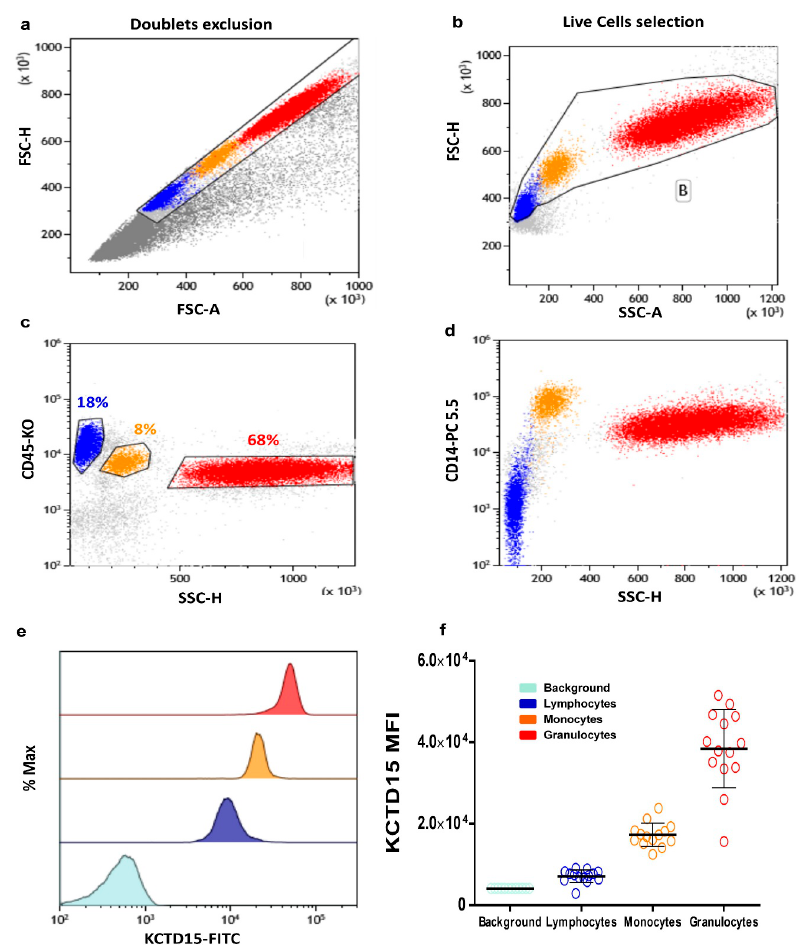
Figure 1. Potassium channel tetramerization domain (KCTD)15 expression in peripheral blood cells. ( a ) Forward scatter (FSC)-Height vs. FSC-Area dot plot used for the selection of single cells and doublets exclusion. ( b ) FSC vs. side scatter area (SSC) dot plot for the selection of single live cells. ( c ) CD45-KO vs. SSC color plot shows the identification of the lymphocytes (blue), monocytes (orange), and granulocytes (red) based on CD45 intensity of expression and light side scatter. ( d ) CD14-PC 5.5 vs. SSC density plot shows the expression of CD14 for better identification of the monocytes. ( e ) Overlay histogram showing the increased KCTD15 fluorescence intensity in granulocytes (red), monocytes (orange), and lymphocytes (blue) when compared to II-FITC antibody-labeled peripheral blood (light blue). ( f ) Scatter plot displaying the mean value of KCTD15 fluorescence intensity with standard deviations (SD) for the background (turkey circles; mean = 4089, SD = 1814), for lymphocytes (blue circles; mean = 7030, SD = 1572), for monocytes (orange circles; mean = 17,223, SD = 2863) and granulocytes (red circles; mean = 38.371, SD = 9597), as derived from the 14 cases studied here. The differences of KCTD15 fluorescence intensity of lymphocytes, monocytes, and granulocytes, compared to the background, are highly significant ( p < 0.001, unpaired t -tests in all cases). Moreover, the difference detected for granulocytes vs. lymphocytes, granulocytes vs. monocytes, and lymphocytes vs. monocytes are also significant ( p < 0.001, unpaired t -tests in all